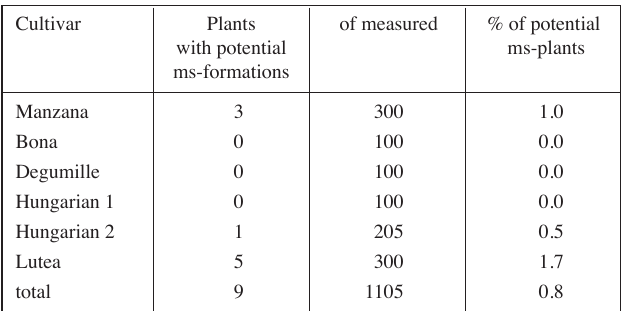
(Fig. 4 and 5). Details of mean pollen sterility of progeny in com- parison with their respective parental cultivars are shown in Tab. 3. The data indicate the increase of pollen sterility by inter-cultivar crossings.